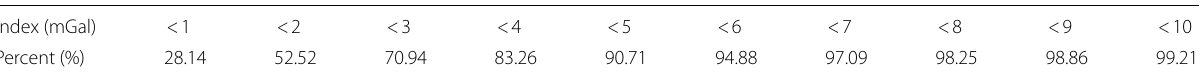
Table 7 Error ratio statistics